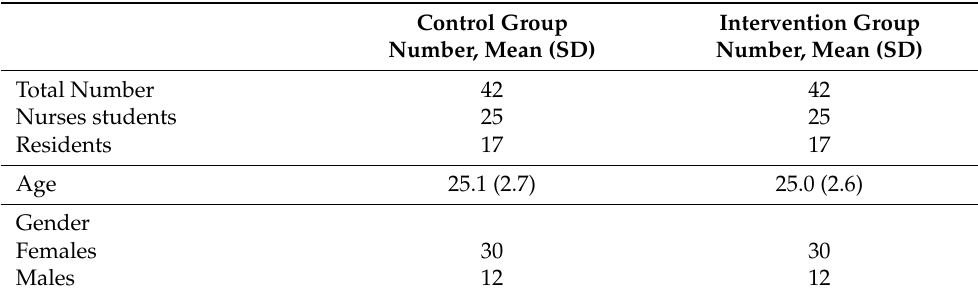
Table 1. Demographic characteristics of the